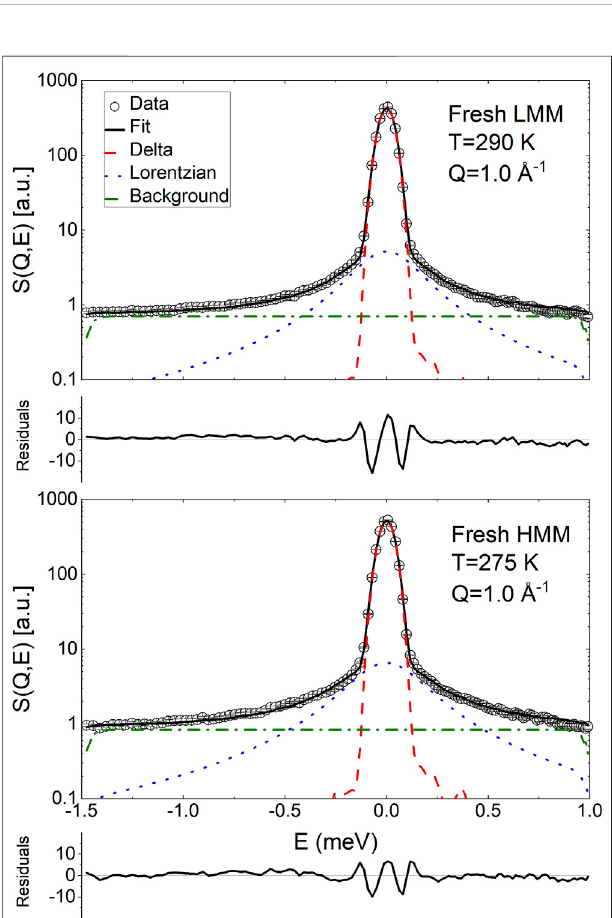
FIGURE 7 | Exemplary fi t of the QENS spectra of fresh low and high molecular mass pyrolytic lignin using Eq. 20 . The normalized residuals ( exp data − fit ) are plotted to provide an indication of the quality of the fi error bar